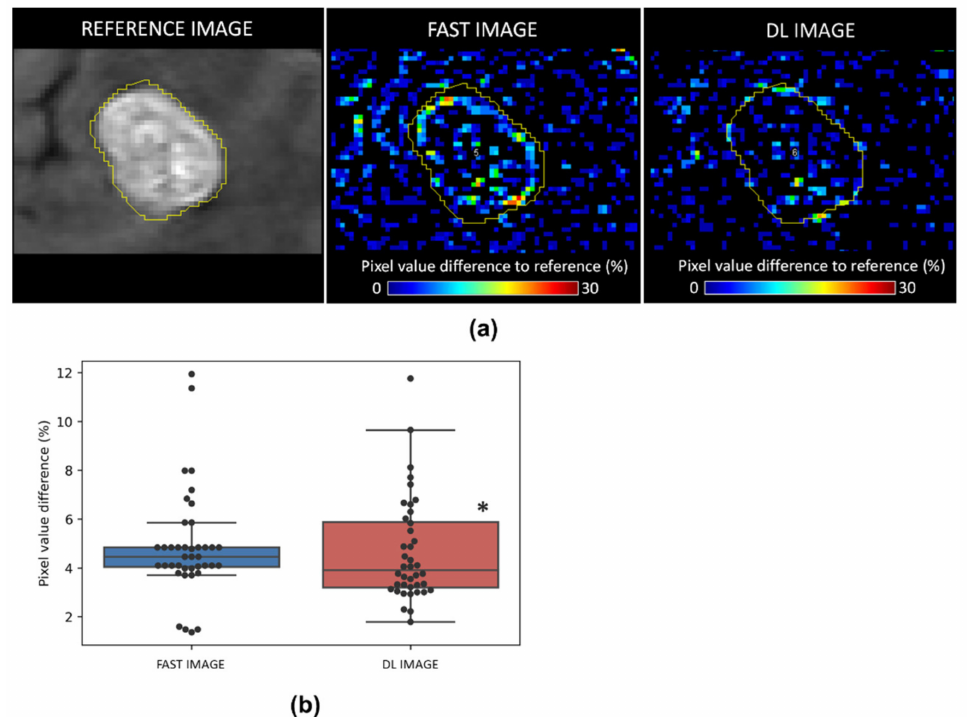
Figure 3. Effect of resampling DL model on BM signal intensity. ( a ) Representative MRI of reference images (left), difference map with fast acquisition images (middle) and DL reconstruction images (right). ( b ) Quantitative analysis of pixel value difference (%) in fast and DL images. n = 40 for both groups, * p < 0.05 vs. fast acquired image. Bars represent minimum and maximum